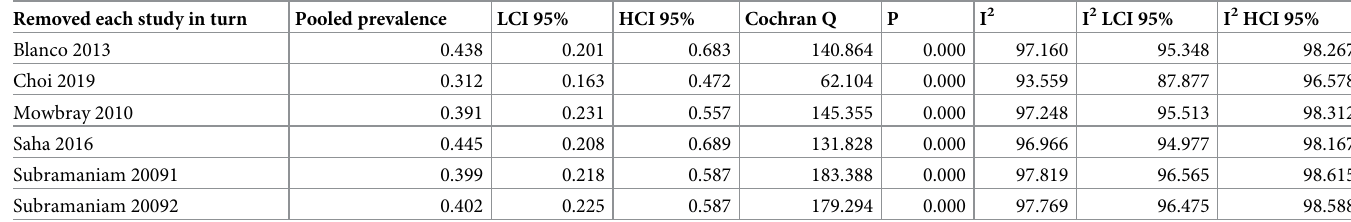
Table 1. Lifetime OUD treatment seeking IVhet base model metaXL sensitivity. Removed each study in turn